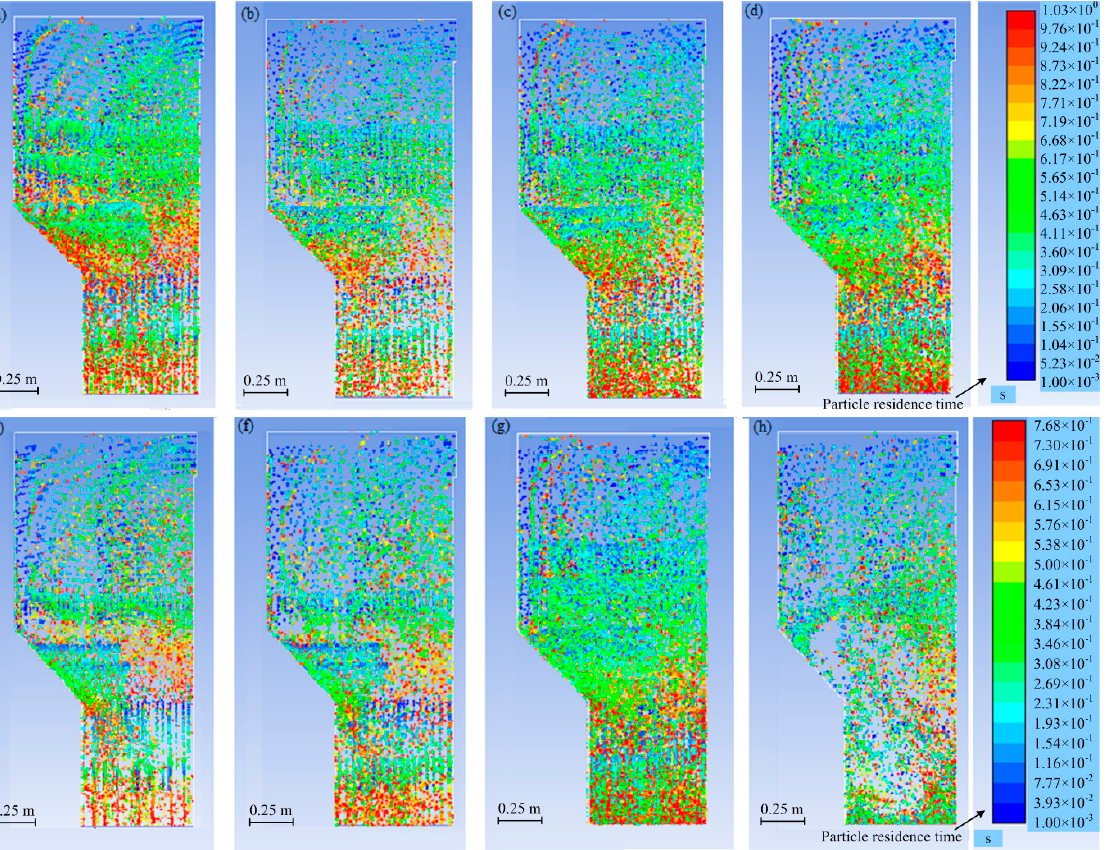
Figure 11. Cloud image of motion trajectories of particles in the chute system running from the start to the end: ( a ) MLG-S 0.5 s; ( b ) MLG-S, 0.6 s; ( c ) MLG-S, 0.7 s; ( d ) MLG-S, 0.8 s; ( e ) MLC-N, 0.5 s; ( f ) MLC-N, 0.6 s; ( g ) MLC-N, 0.7 s; ( h ) MLC-N, 0.8 s.